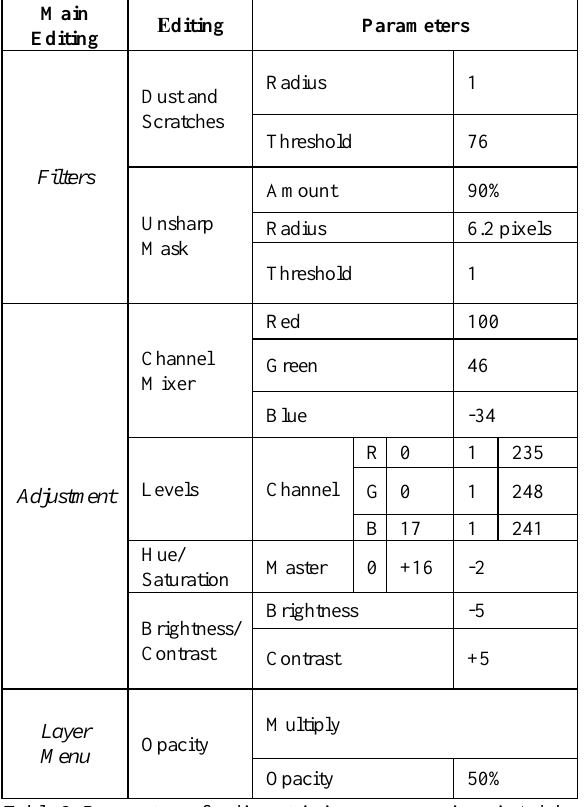
Table 3. Parameters of radiometric image processing via Adobe Photoshop